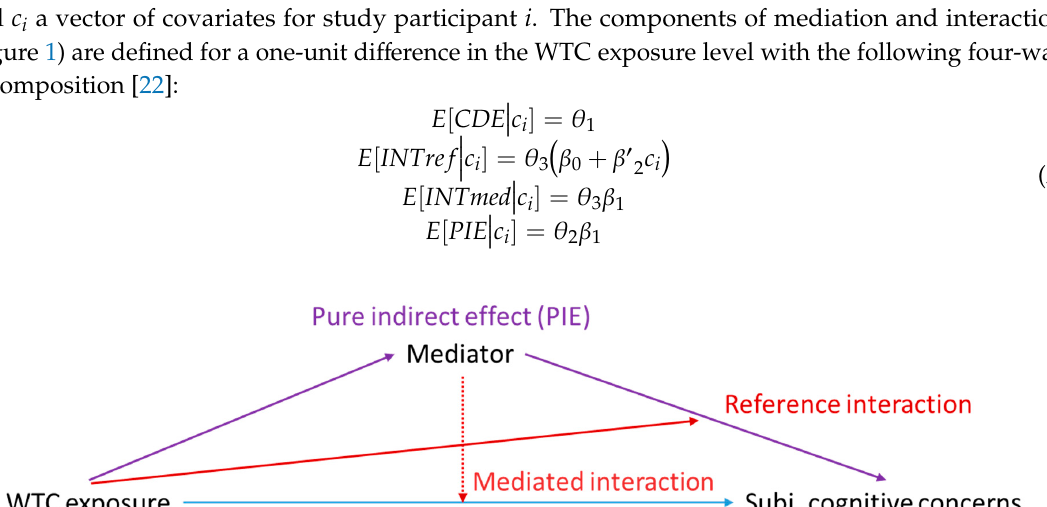
CFI completion only.